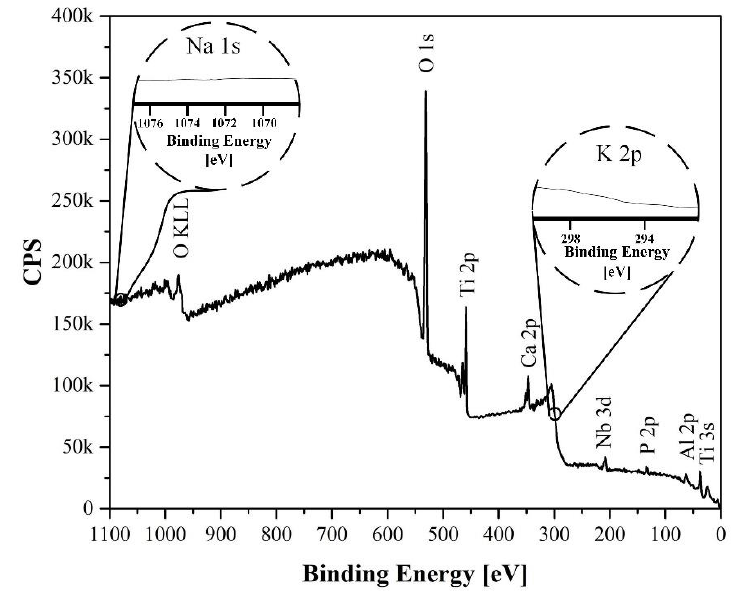
Figure 5. XPS survey spectra for sample S1 HTT.